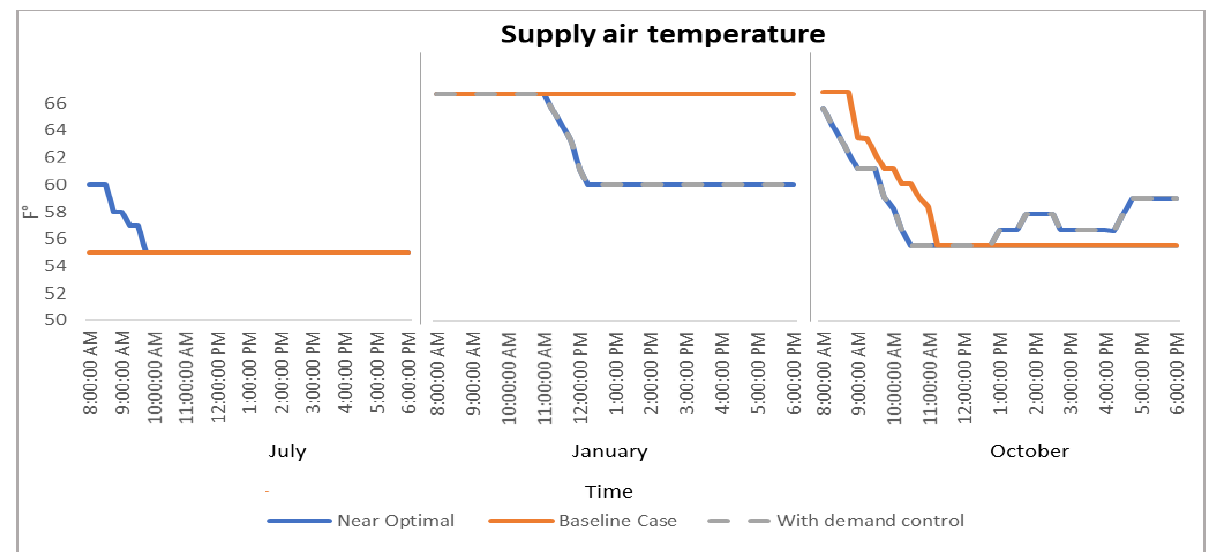
Figure 10. The five zones supply air temperature for each day being analyzed.